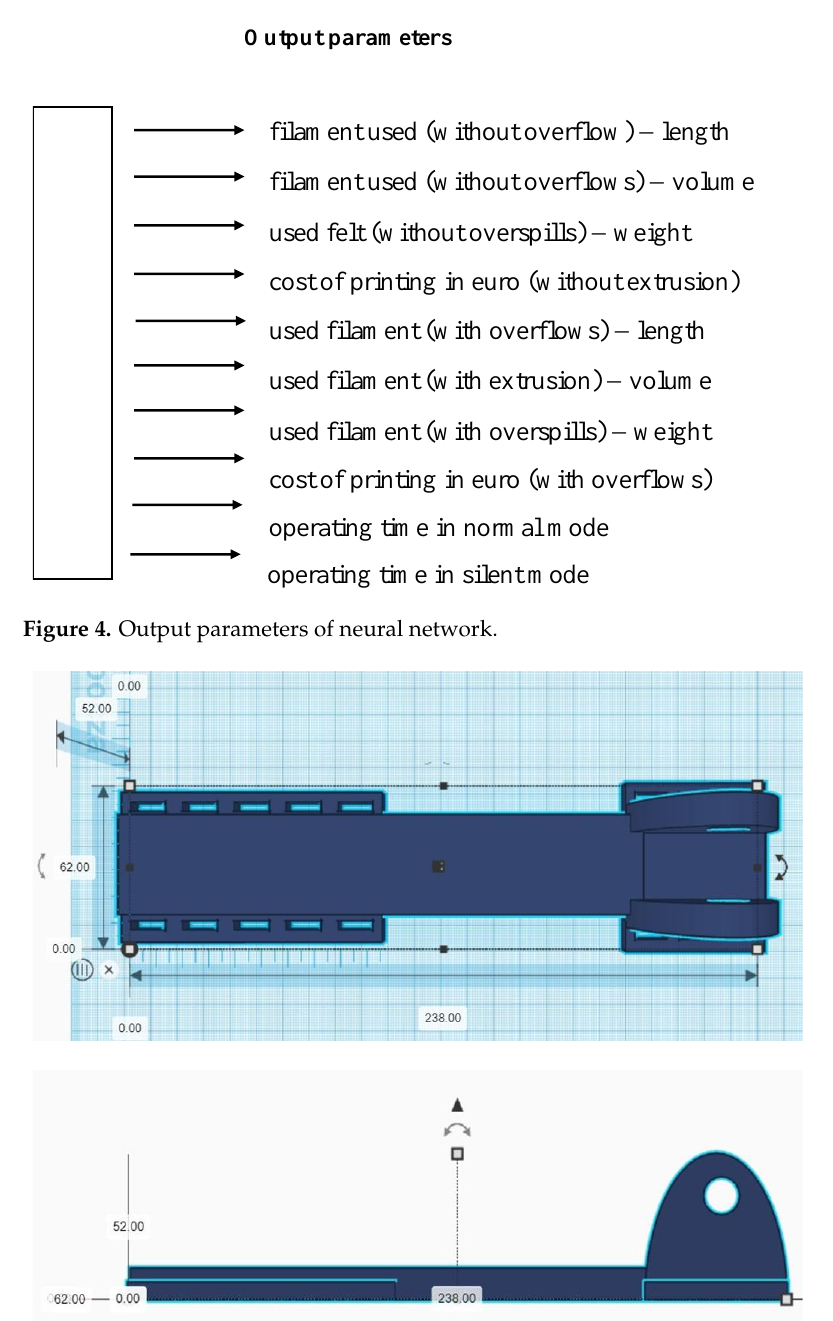
Figure 5. Optimized part of the exoskeleton.